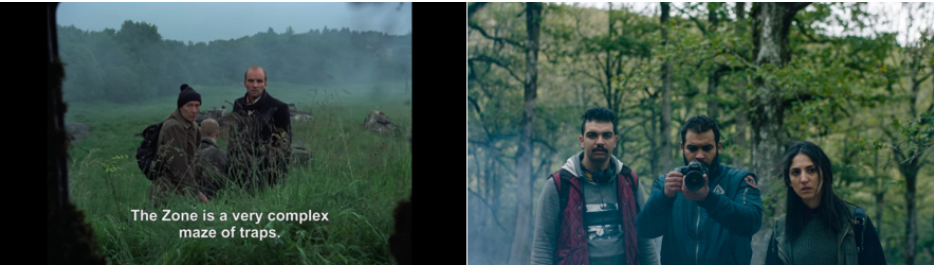
Figure 17: In Dachra as in Stalker, a trio discovers an